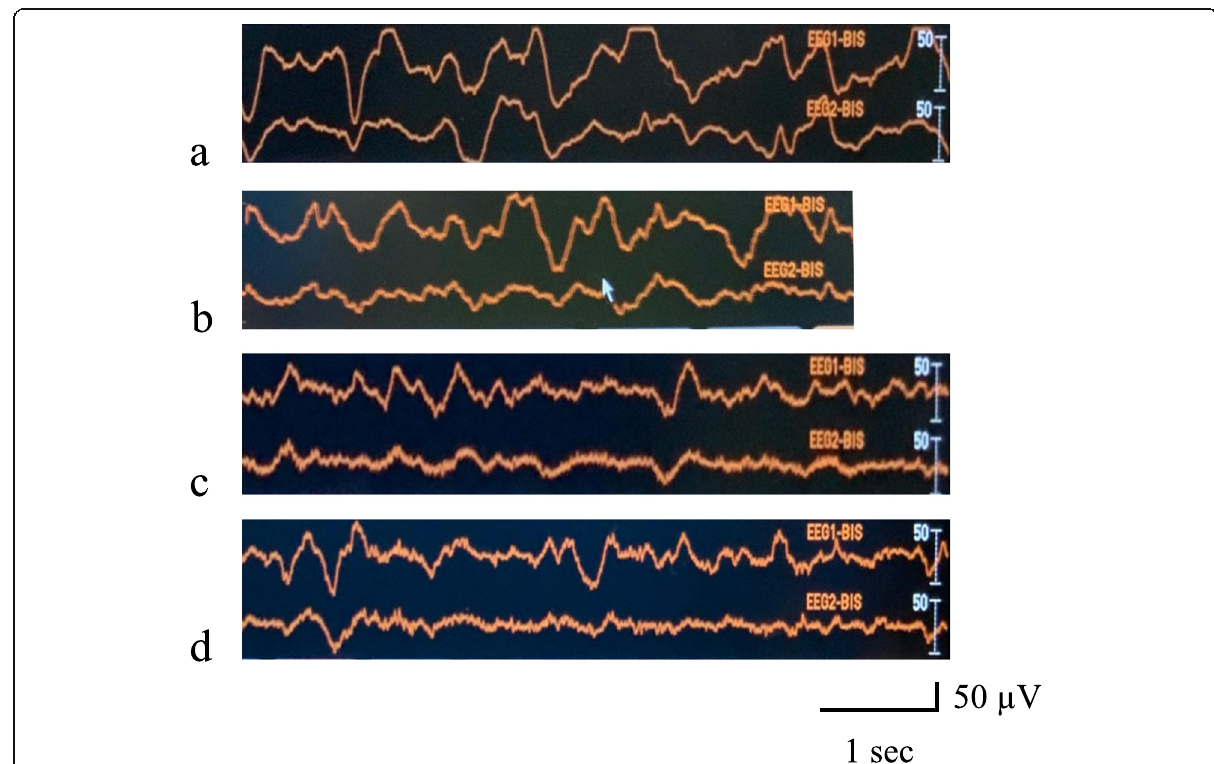
Fig. 3 a – d Electroencephalogram recorded by the BIS monitor at each phase of liver transplantation. EEG1-BIS and EEG2-BIS were obtained from between the middle of the forehead and above the left eyebrow, and between the middle of the forehead and the left pre-auricular area, respectively. a The BIS value was 15 with high voltage and slow waves (0.5 – 1 Hz) in the dissection-anhepatic phase. b The BIS value was 24 with high voltage and slow waves (0.5 – 1 Hz) in the reperfusion phase. c The BIS value was 38 with moderate amplitude and slow waves (2 – 3 Hz) in the neo-hepatic phase. d The BIS value was 55 with moderate amplitude and slow waves (2 – 4 Hz) at the time of wound